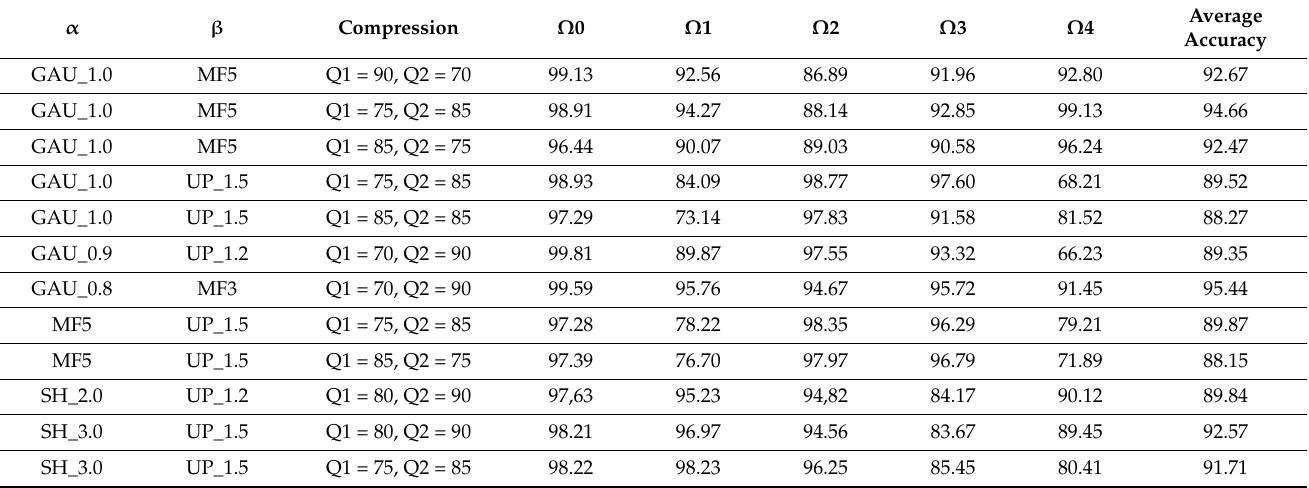
Table 2. Operator sequence detection on compressed images with similar specifications.